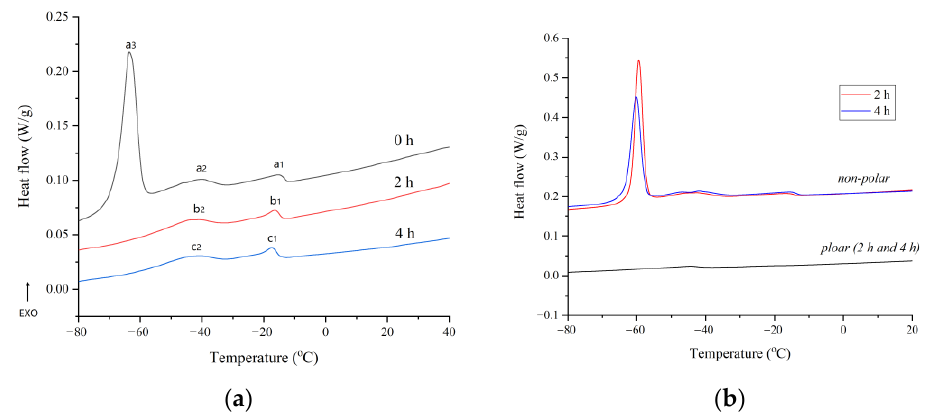
Figure 3. Cooling thermograms of flaxseed oil and its fraction at different heating times: ( a ) flaxseed oil; ( b ) polar and nonpolar fraction of flaxseed oil.